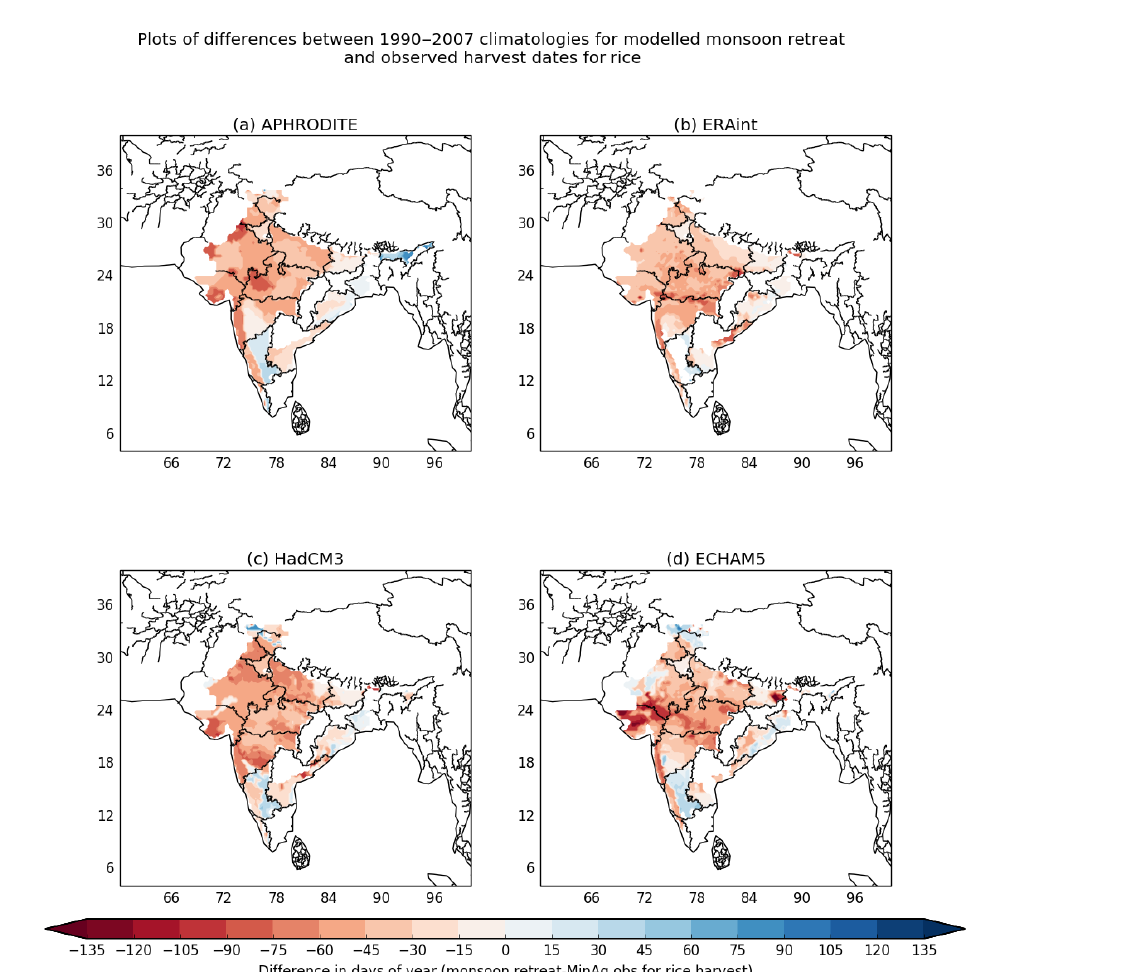
Figure B1. The difference between the midpoint of the monsoon retreat in the model and the midpoint of the observed rice harvest period for